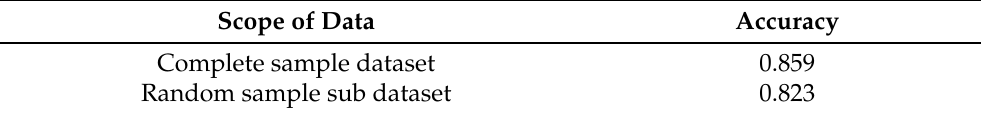
Table 7. An analysis of the calculated SOD results before and after random sampling was